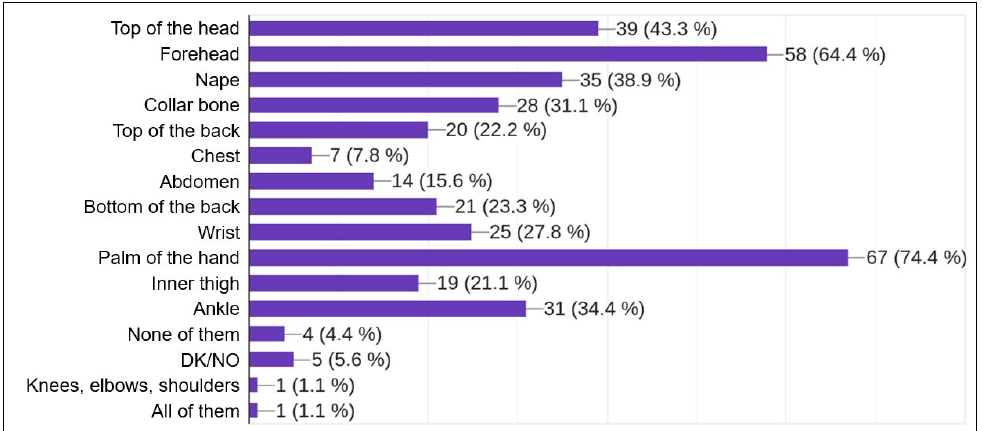
Figure 14. Answers to question: parts of the body where sensor placement would hinder your